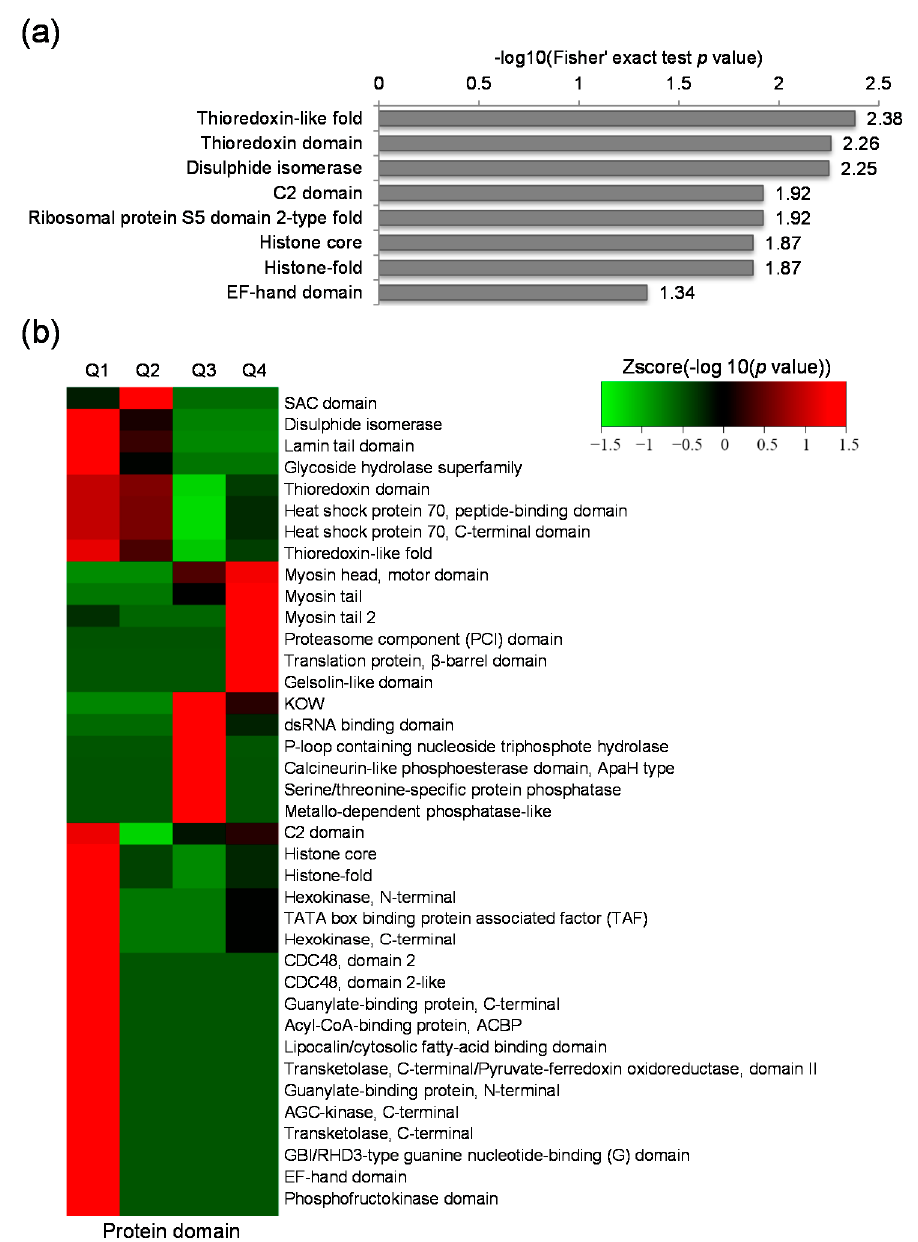
Figure 4. Protein domain analysis of the differentially expressed lysine acetylated proteins. ( a ) Protein domain enrichment analysis; ( b ) Protein domain based clustering analysis.